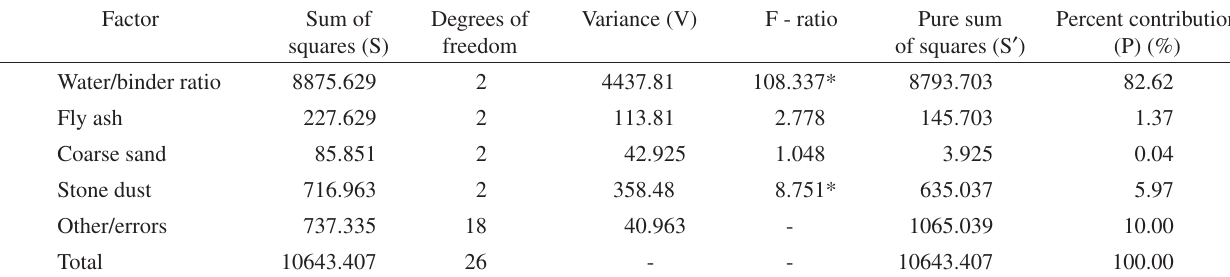
characteristic.Water/binder Figure 3. Effects of process parameters on mean response Table 6. Analysis of variance (ANOVA) for compressive strength. Factor Sum of Degrees of squares (S) freedom Stone